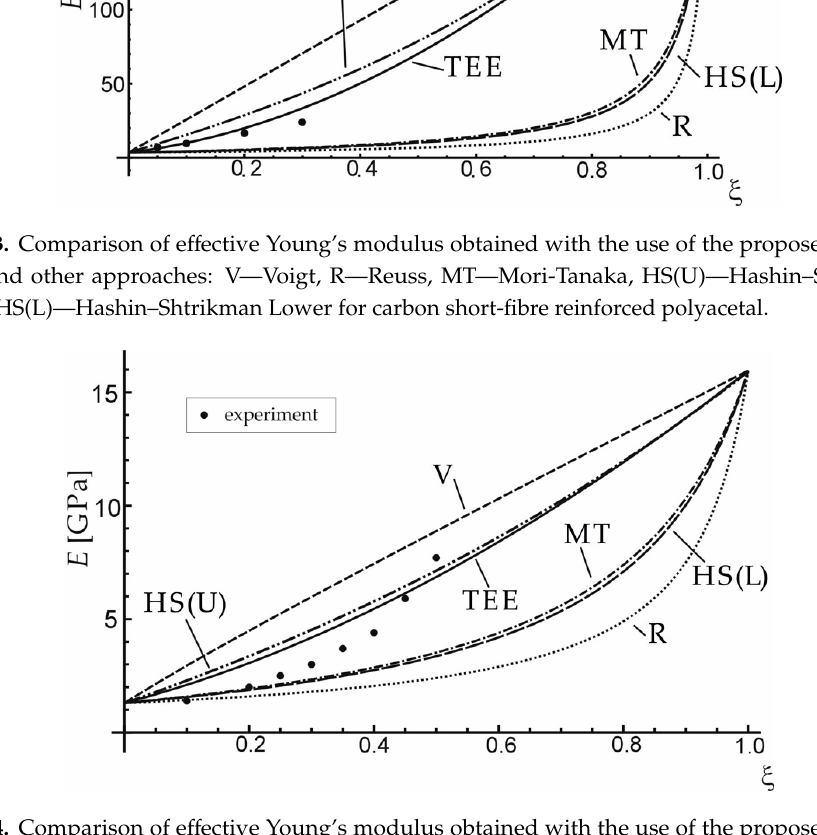
Figure 4. Comparison of effective Young’s modulus obtained with the use of the proposed method (TEE) and other approaches: V—Voigt, R—Reuss, MT—Mori-Tanaka, HS(U)—Hashin–Shtrikman Upper, HS(L)—Hashin–Shtrikman Lower) for hydroxyapatite reinforced PE. Data adapted from References [29,30]. Table 4. Material properties of matrix polyacetal POM T-300 and carbon short-fibre “Fortafil F-3.” Young Modulus Material